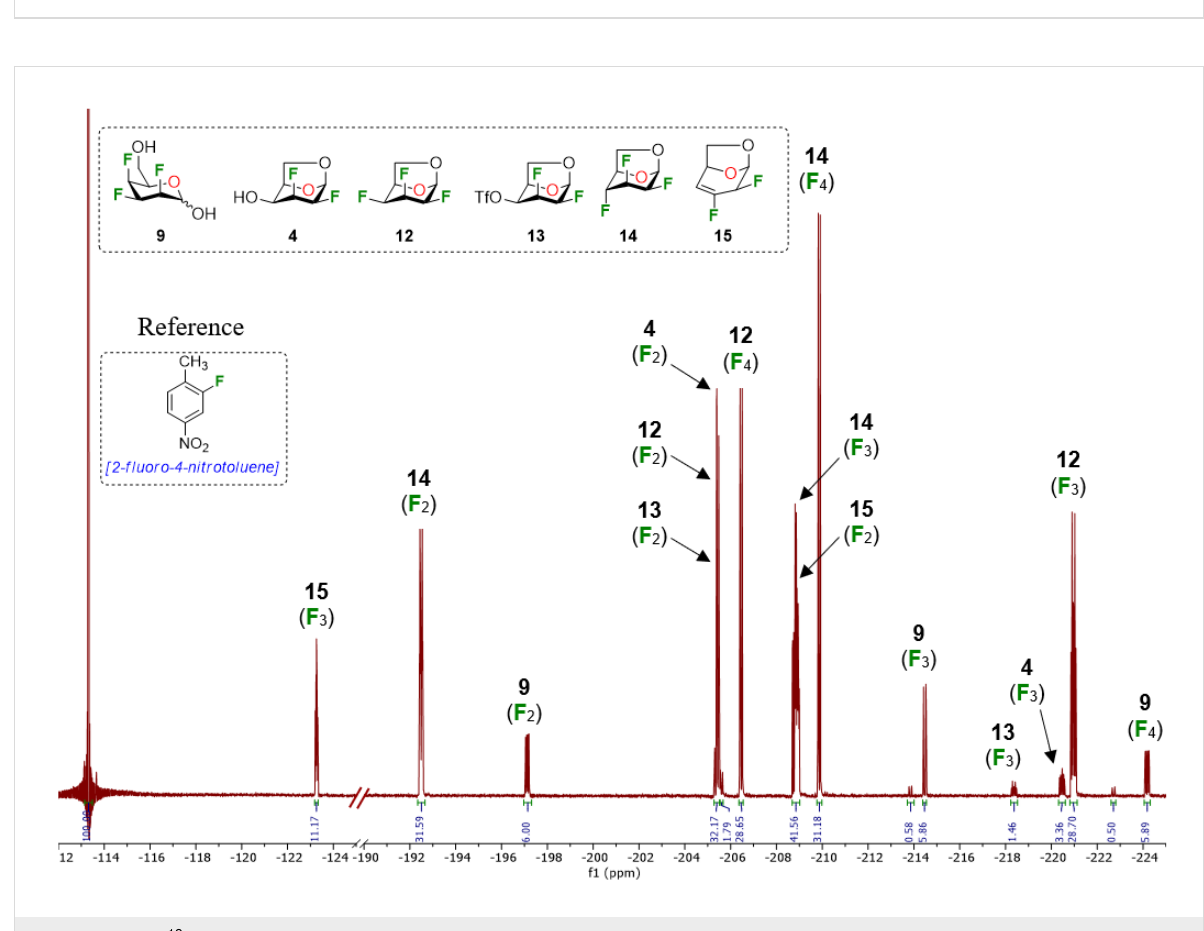
Figure 2: Typical 19 F NMR spectrum (470 MHz, CDCl 3 ) of the crude reaction mixture using Et 3 N·3HF/Et 3 N (entry 3 of Table